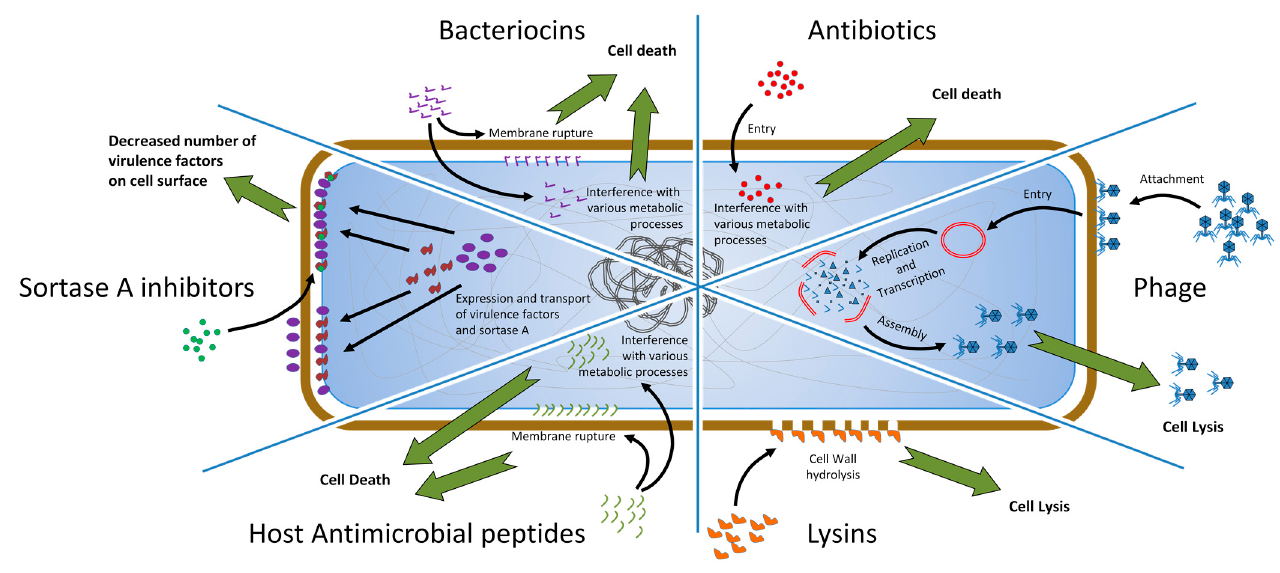
Figure 1. Conceptual sexpartite diagram comparing simplified modes of action for antibiotics and some of the alternative approaches to combat the pathogenic bacteria. The diagram is divided into six parts, each corresponding to the given approach for combating the Gram-positive pathogenic bacteria. Brown rounded rectangle represents peptidoglycan layer and together with the contents represents the Gram-positive bacterial cell. Perimeter of the blue rounded rectangle represents the plasma membrane. Black arrows represent interactions and point at the desired spatial location/locations of the agents for interplay with their bacterial targets. Green arrows pointing away from the cell represent the desired outcome of an interplay between a given agent and its target. Colored figures unique to each of the diagram parts represent agents that can be viewed as an alternative to antibiotics (for example red circles represent molecules of antibiotics). In the case of sortase A (SrtA) inhibitors (leftmost part of the diagram): Green circles—inhibitory compounds, purple ellipses—virulence factors, amorphous brown figures—SrtA enzyme.